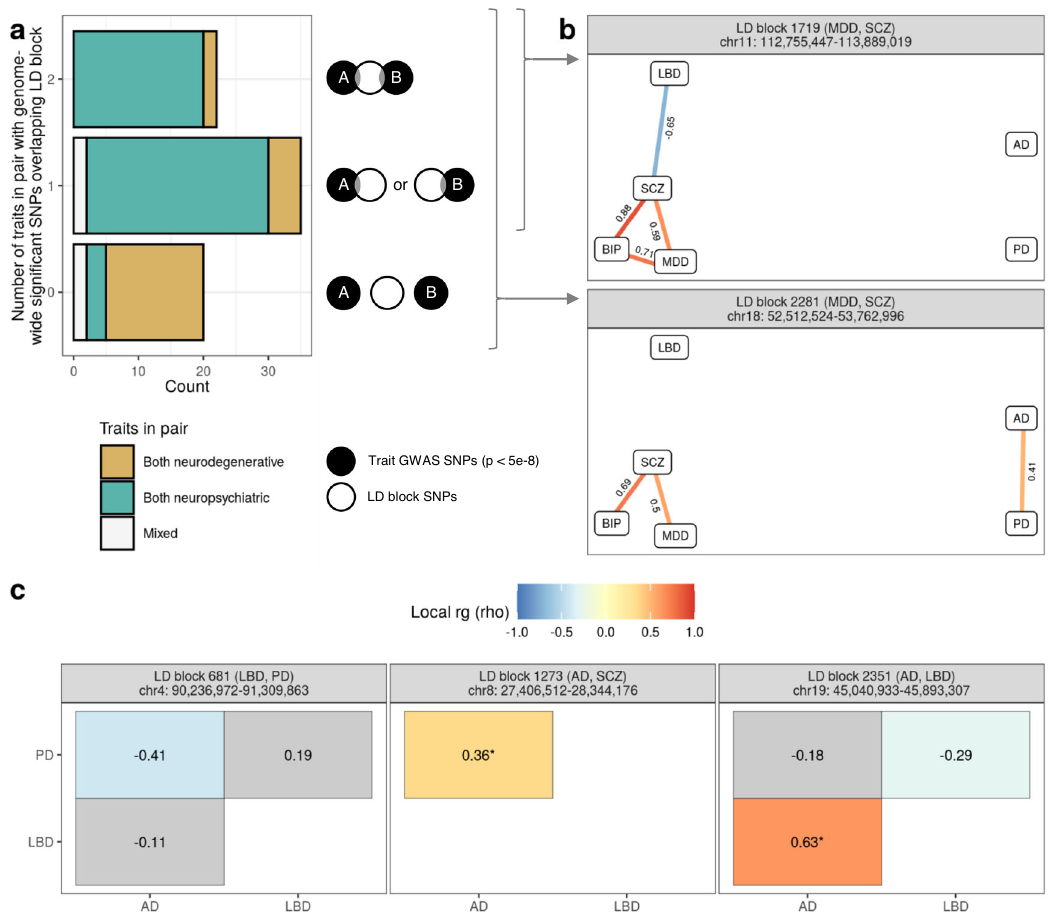
Fig. 2 Local analyses associate disease-implicated genomic regions with previously unrelated traits. a Bar plot (left) showing the number of traits within trait pairs demonstrating signi fi cant local r g s that had genome-wide signi fi cant SNPs overlapping the tested LD block (as illustrated by the schematic on the right). b Two LD blocks illustrating the situations depicted in ( a ). Edge diagrams for each LD block show the standardised coef fi cient for r g (rho, ρ ) for each signi fi cant bivariate local r g . Signi fi cant negative and positive r g s are indicated by blue and red colour, respectively. c Heatmaps show the rho for each bivariate local r g within the LD block. Asterisks (*) indicate r g s that were replicated when using AD and PD GWASs that excluded UK Biobank by-proxy cases. Signi fi cant negative and positive r g s are indicated by blue and red fi ll, respectively. Non-signi fi cant r fi ll. In both ( b , c ) panels are labelled by the LD block identi fi er, the traits with genome-wide g s have a grey signi fi cant SNPs overlapping the LD block (indicated in the brackets) and the genomic coordinates of the LD block (in the format chromosome:start-end,